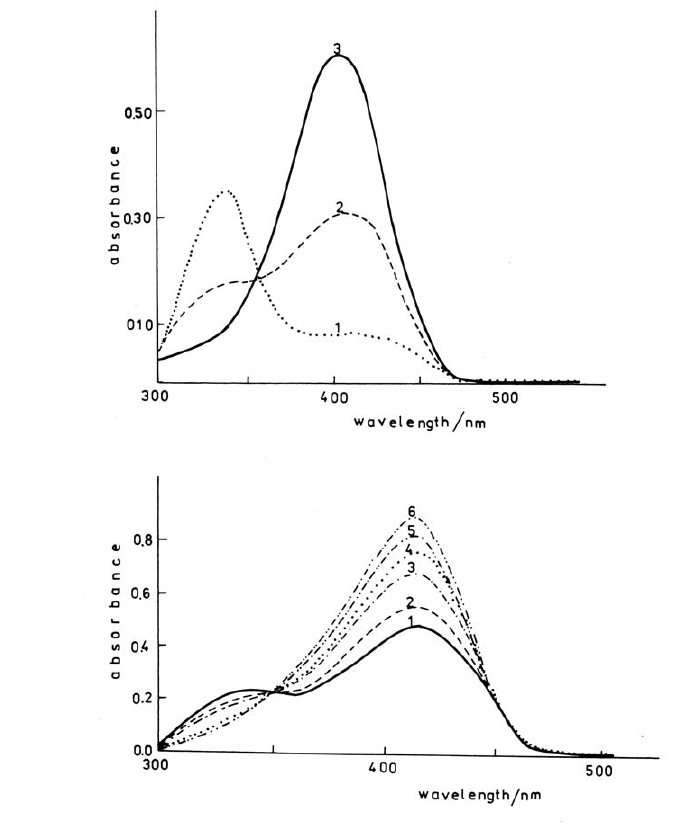
Figure 2. Dependence of electronic absorption spectra of 2-(N-methyl- α -iminoethyl)-4,6- dichlorophenol on solvent polarity; 1 – CCl 1 – 298 K, 2 – 273 K, 3 – 248 K, 4 – 233 K, 5 – 213 K, 6-183 (lower picture)